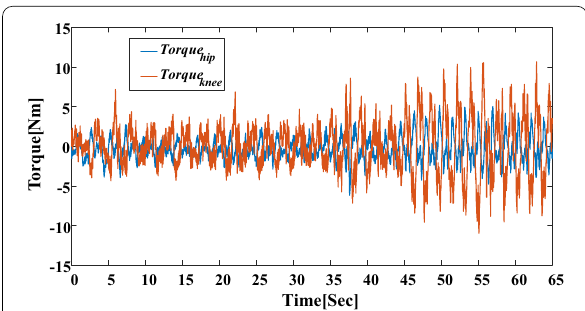
Figure 15 Human-robot interaction torque by using the variable admittance controller in exoskeleton active